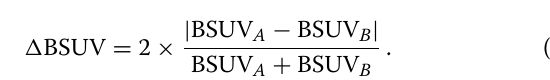
The described procedure essentially avoids partial vol- ume effects (spill out as well as spill in) even in case of an obvious eccentric positioning of the ROI within the